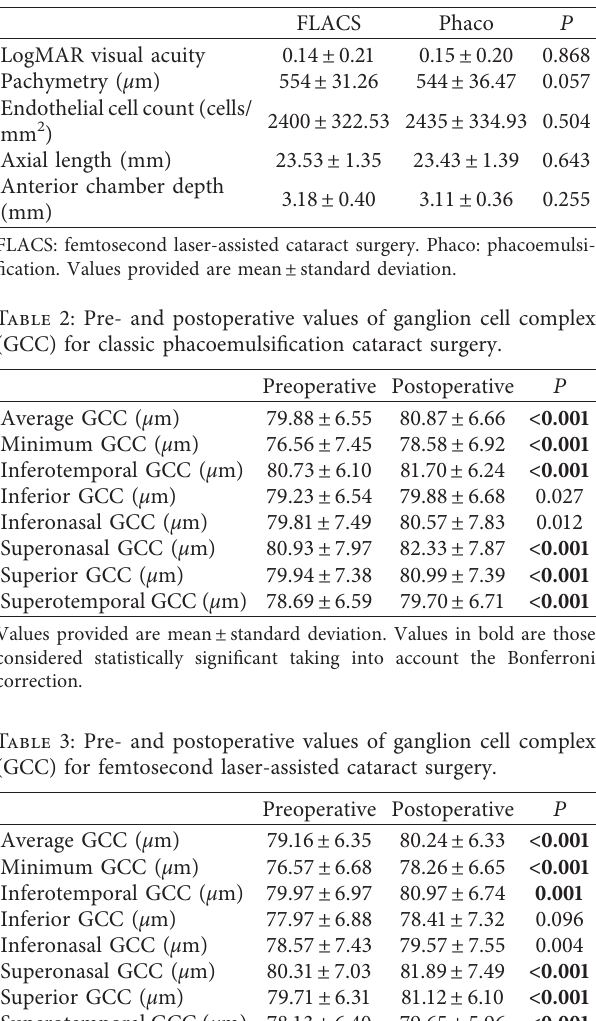
Table 1: Preoperative characteristics of the eyes included in the study.